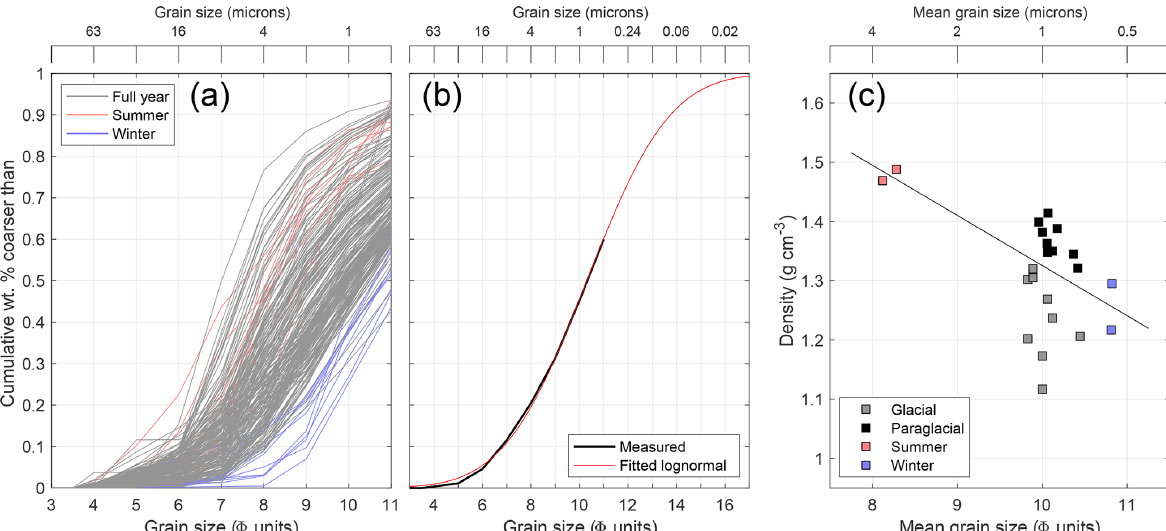
Figure 3. Grain size and sediment density measurements. (a) Measured cumulative grain size distributions for summer layers (red), winter layers (blue), and complete single or multiple varves (gray). Pipette analysis stopped at 11 (cid:56) . (b) Example of extrapolating measured grain size data for a representative sample (NAVC 7068-69 from the NHV section) using a fitted lognormal distribution. (c) Relationship between sediment dry density and grain size. The linear approximation shown by the black line (which is fit to all data excluding three low outliers that likely result from failure to completely fill the reference volume with stiff glacial sediment) is used in subsequent flux